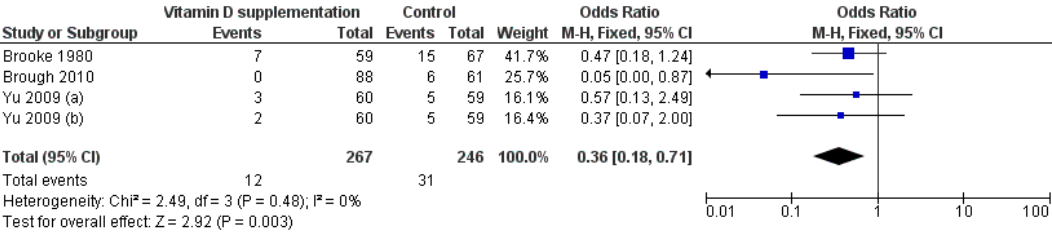
Figure 5. Forest plot of the effect of vitamin D intervention on the risk of low birthweight, based on the fixed-effects model. Yu 2009 ( a ): Vit D2 (800 IU/day); Yu 2009 ( b ): Vit D2 (single dose of 200000 IU).